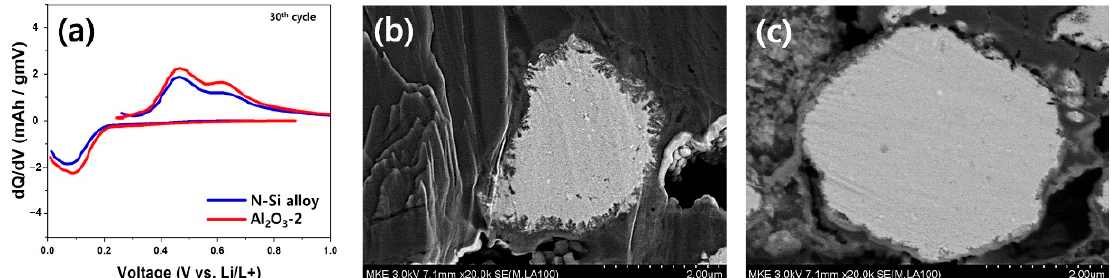
Figure 9. ( a ) Differential capacity plots of the N-Si alloy and Al 2 O 3 -2 powders, obtained after 30 charge/discharge cycles. SEM images of the ( b ) N-Si alloy and ( c ) Al 2 O 3 -2 powders after 30 charge/discharge cycles.